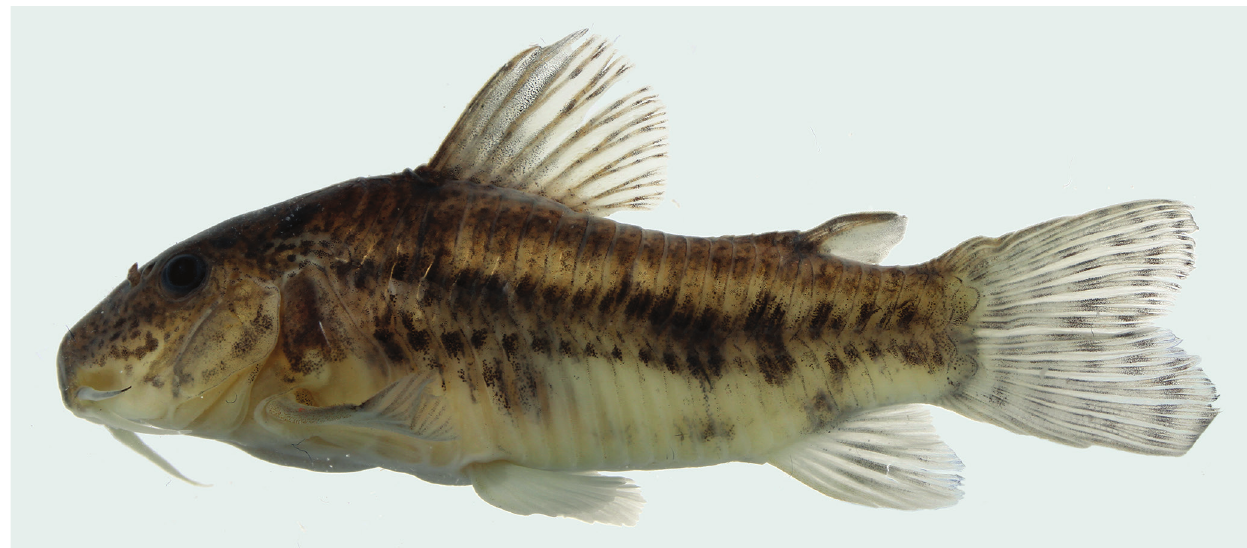
Fig. 1. Scleromystax reisi , holotype, male, MCP 49070, 49.3 mm SL, arroio Demétrio, Morungava, Gravataí, RS, Brazil. Description. Morphometric data presented in Table